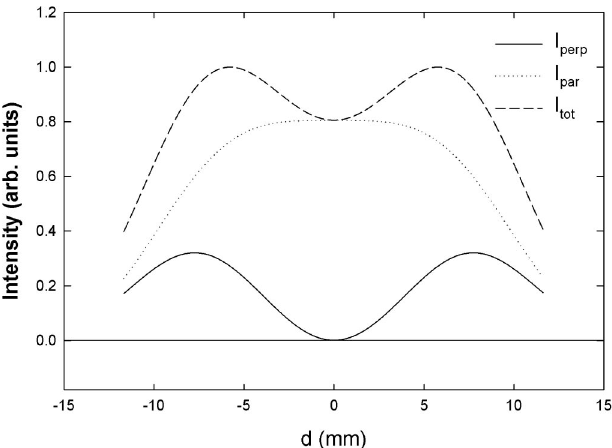
FIG. 2. A calculation of the angular distribution of the out-of- plane OSR from the upstream dipole projected at a distance of 5.8 m and using a wavelength of 500